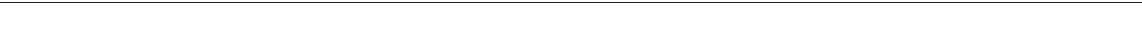
recruited to the DSBs in S-phase. U2OS AsiSI were synchronized in S-phase (4 h post release from double thymidine block). Chromatin was prepared from these S-phase cells grown without ( − 4-OHT) or after 4 h of 4-OHT treatment. ChIP was carried out using a anti-BLM antibody; b anti-RAD51 antibody;